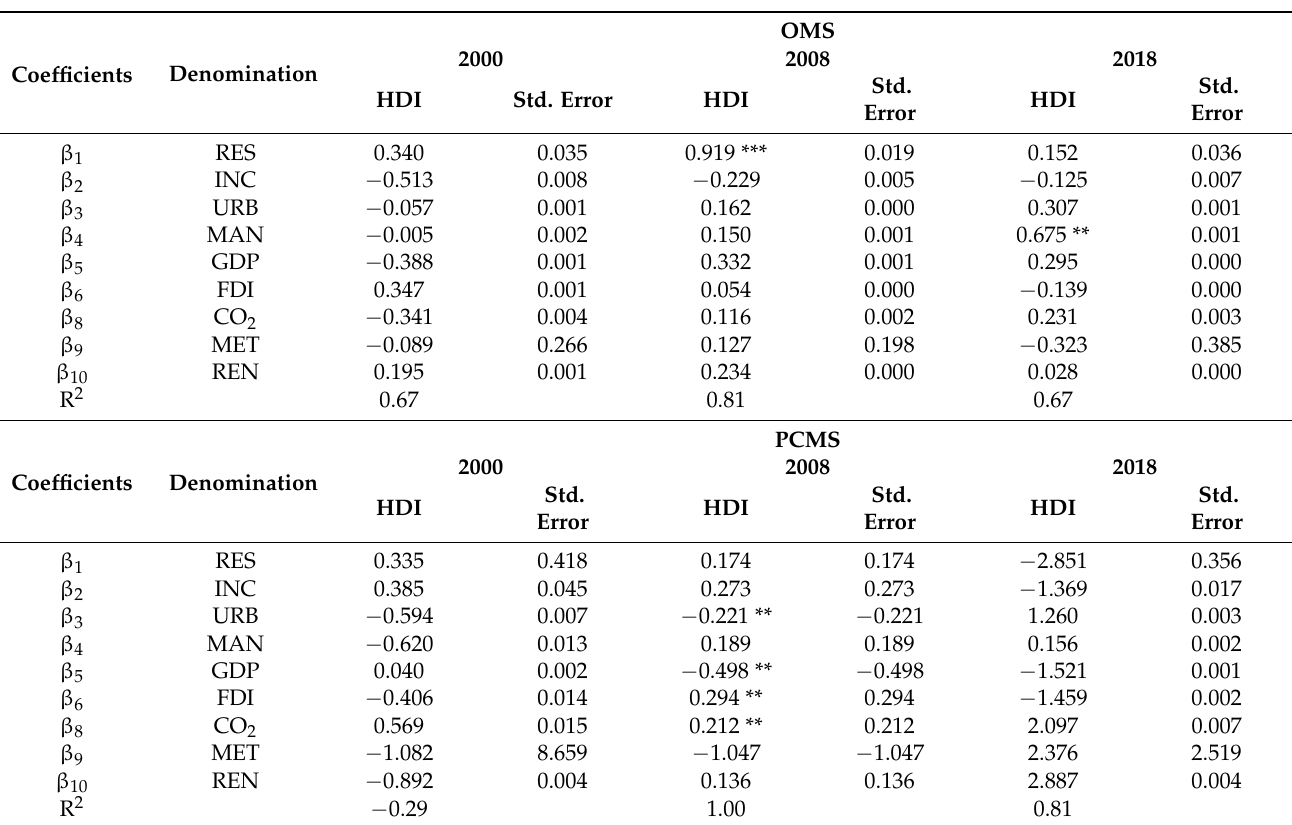
Table 5. Regression